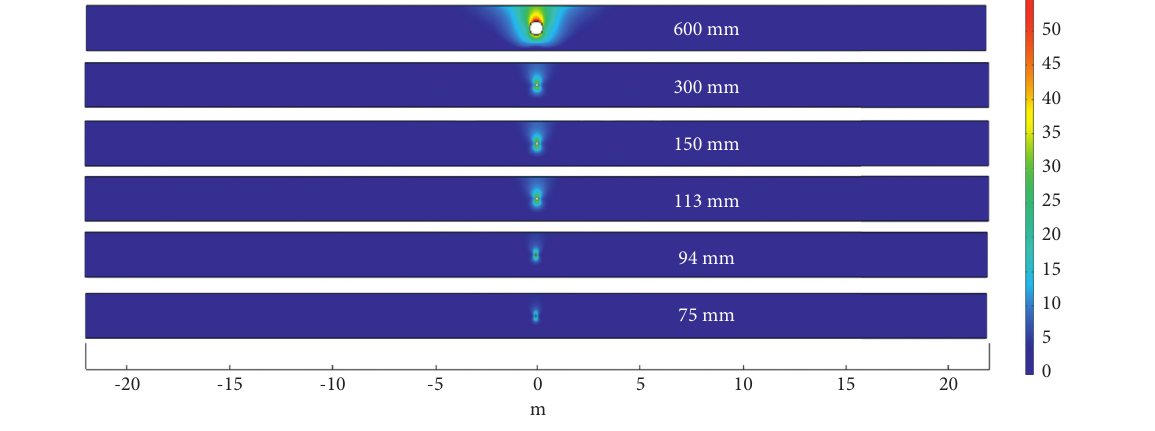
Figure 6: Displacement cloud of different hole sizes.